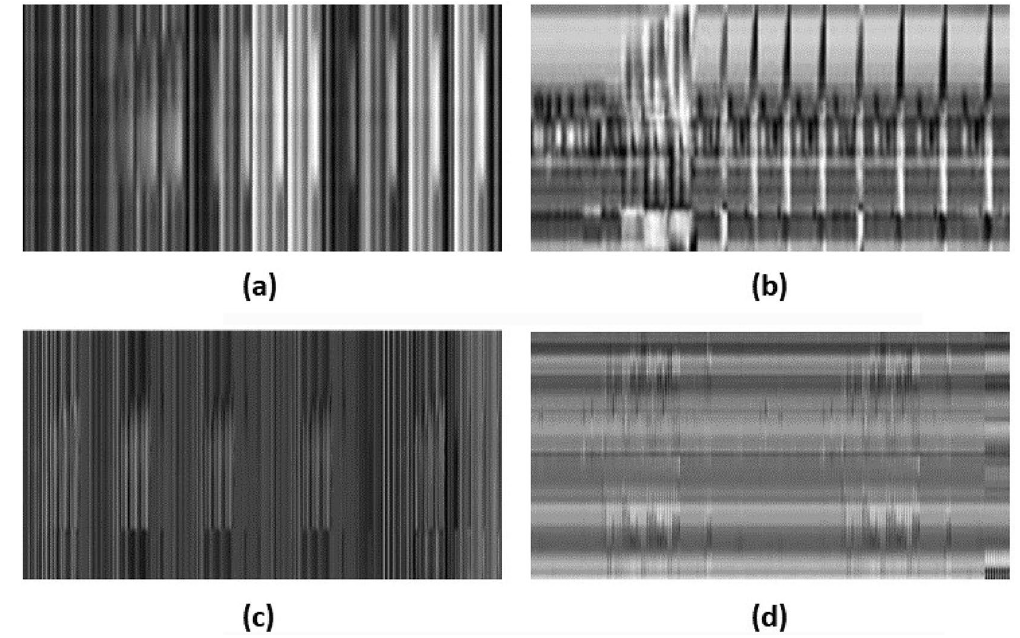
Figure 2. Encoded gray-scale images generated from four different features: ( a ) distance ( b ) distance velocity ( c ) angle, and ( d ) angle velocity features obtained from the UTD-MHAD dataset. Angle features contain more expressive information as compared to distance